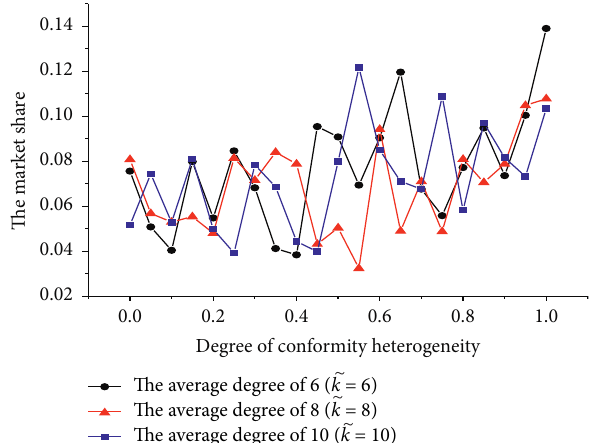
Figure 7: Effects of conformity heterogeneity on the diffusion scale based on different network